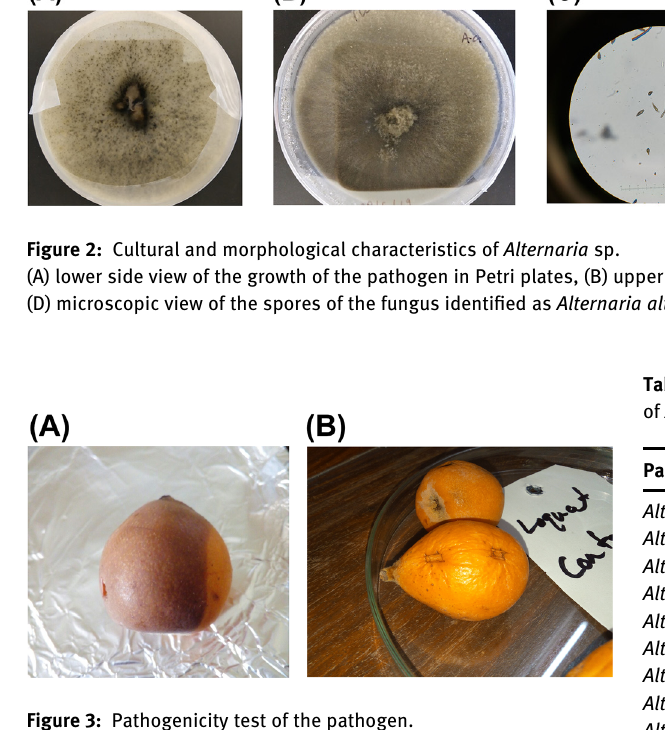
Figure 3: Pathogenicity test of the pathogen. (A) Shows the symptoms of fruit rot con fi rming the pathogenicity however, (B) fruits are symptomless in the control set.